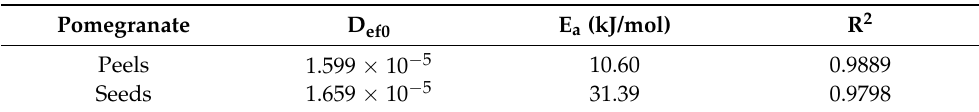
Table 6. The activation energy (E a ),coefficients of determination (R 2 ) and pre exponential factor (D ef0 ) of pomegranate peels and seeds.